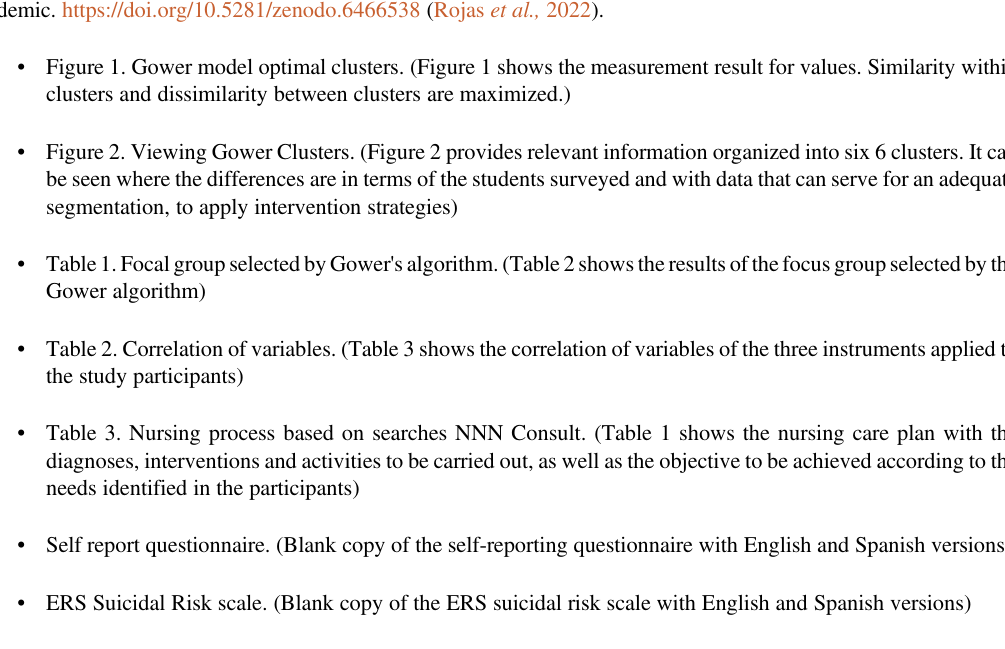
(cid:129) Figure 1. Gower model optimal clusters. (Figure 1 shows the measurement result for values. Similarity within clusters and dissimilarity between clusters are maximized.)